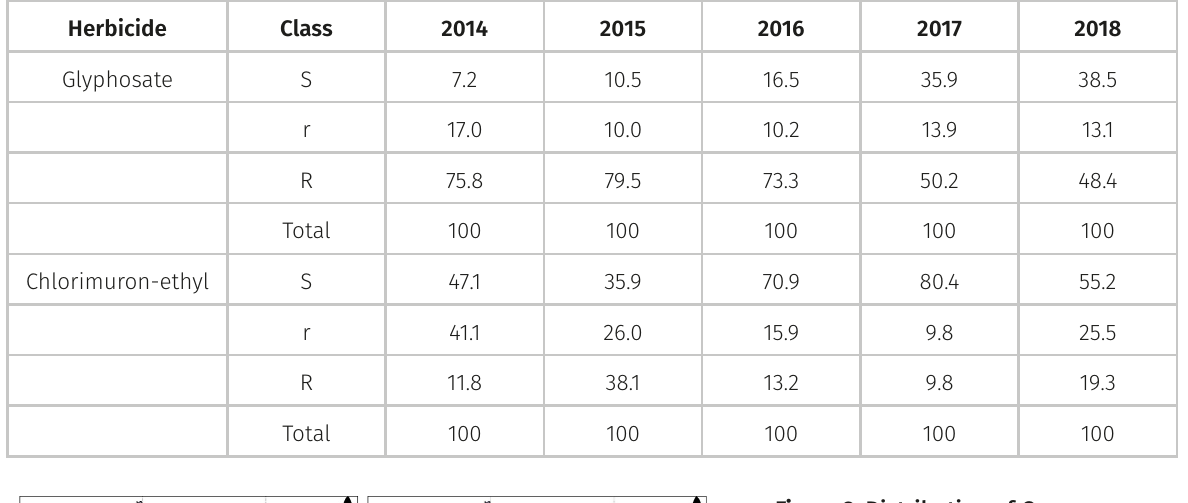
Figure 2. Distribution of Conyza spp. populations resistant to glyphosate in Brazil between 2014 and